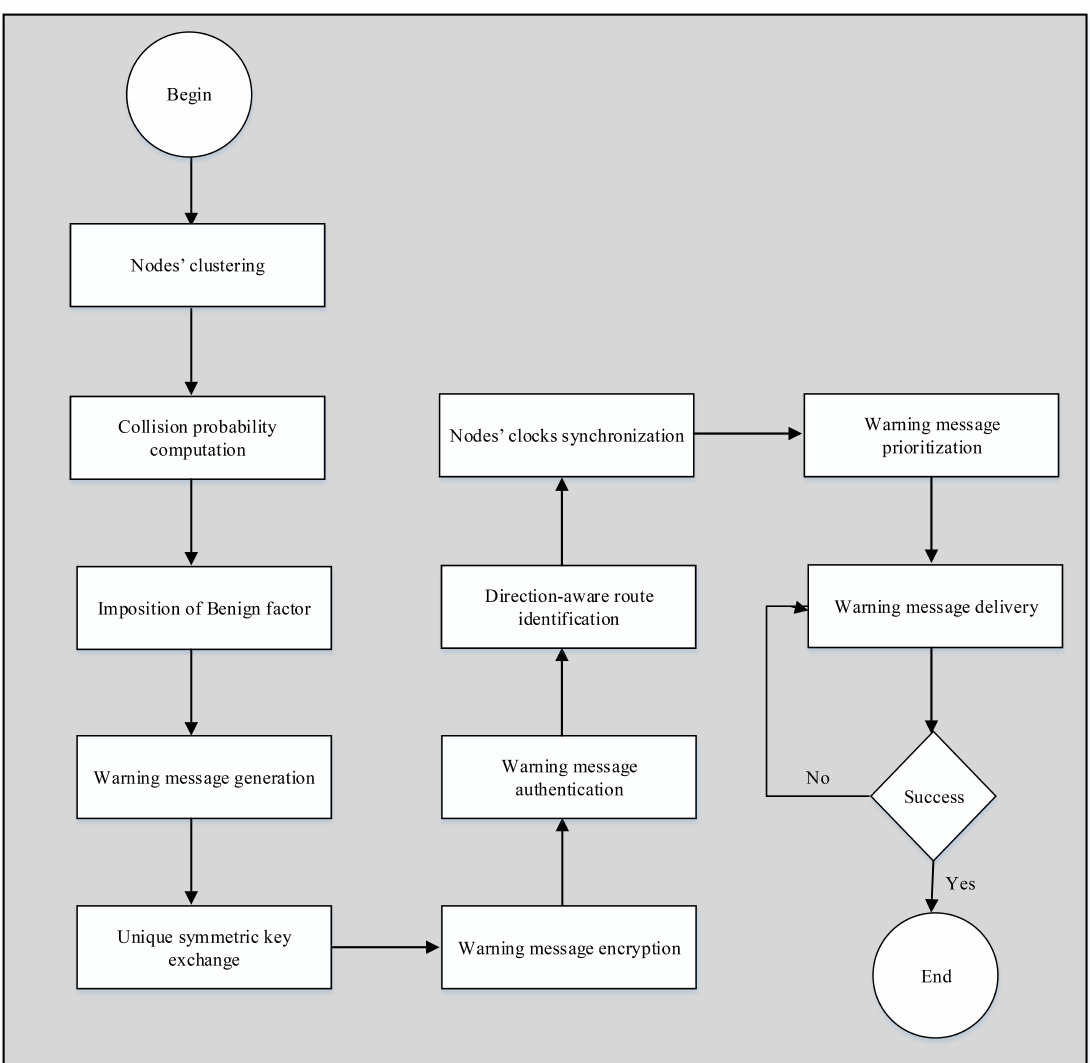
Figure 4. Procedural flowchart of the proposed DVCA